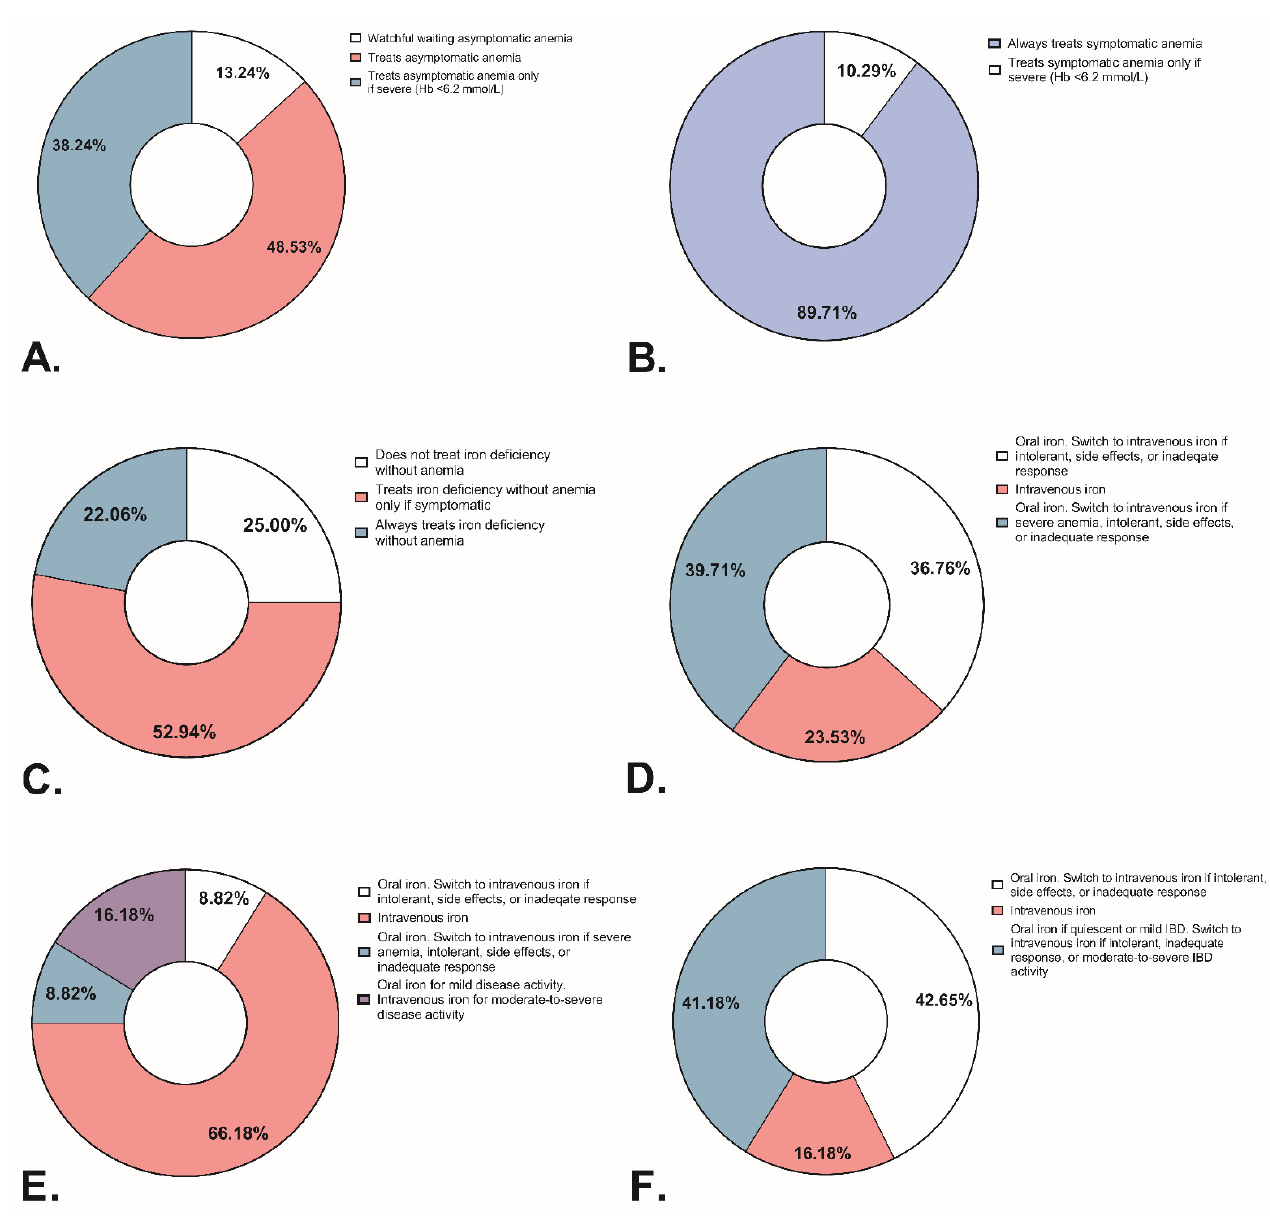
Figure 3. Respondent data regarding the treatment of iron deficiency with or without anemia in patients with Inflammatory Bowel Disease. ( A ) Percentage of respondents prescribing treatment for asymptomatic anemia. ( B ) Percentage of respondents prescribing treatment for symptomatic anemia. ( C ) Percentage of respondents prescribing treatment for iron deficiency without anemia. ( D ) Percentage of respondents and their chosen therapy for iron-deficiency anemia in quiescent IBD. ( E ) Percentage of respondents and their chosen therapy for iron-deficiency anemia in active IBD. ( F ) Percentage of respondents and their chosen therapy for iron deficiency without anemia. Hb: